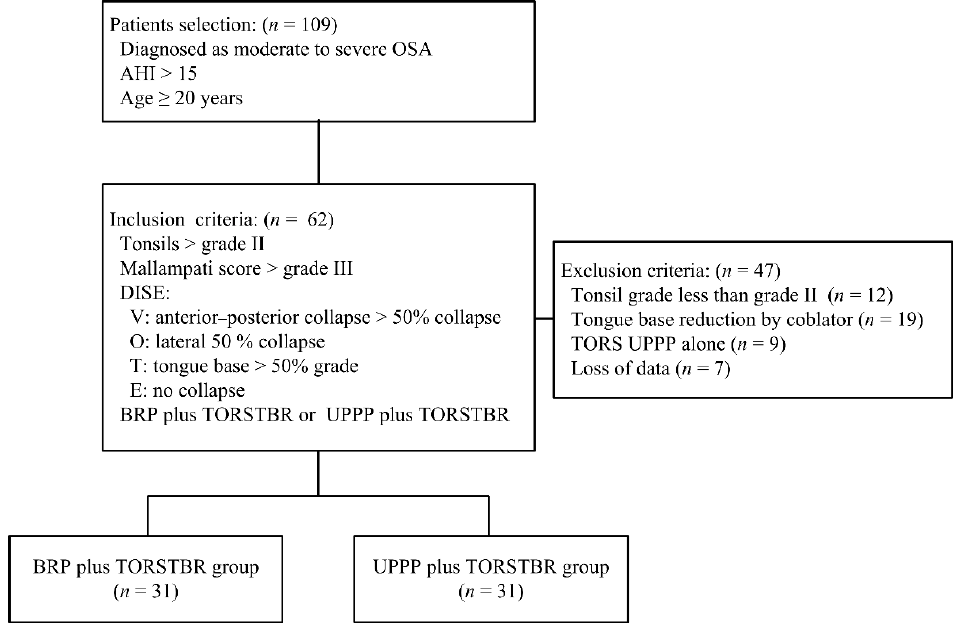
Figure 1. The flow chart of the current study. OSA, obstructive sleep apnea; AHI, apnea–hypopnea index; BRP, barbed repositioning pharyngoplasty; TORSTBR, transoral robotic tongue base reduction; UPPP, uvulopalatopharyngoplasty.